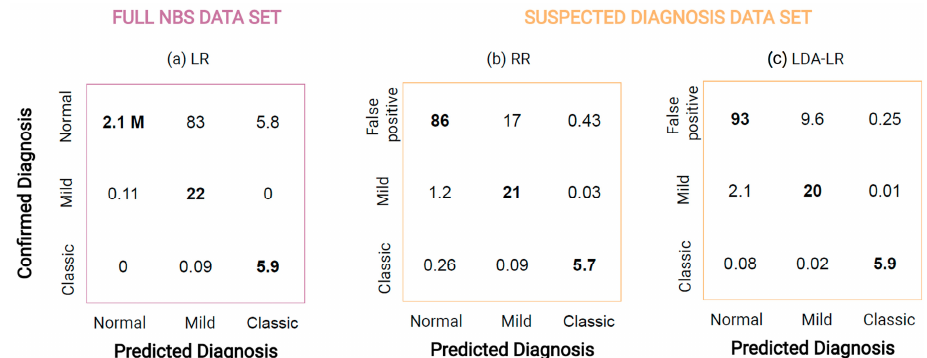
Figure 5. Confusion matrix displaying mean results of 100 independent runs for classification of normal (including false positives), mild IVA, and classic IVA applying ( a ) LR on full NBS data set and for classification of false positive, mild IVA, and classic IVA applying ( b ) RR on suspected diagnosis data set and ( c ) LDA-LR on suspected diagnosis data set. Prediction agreeing with the confirmed diagnosis is highlighted in bold